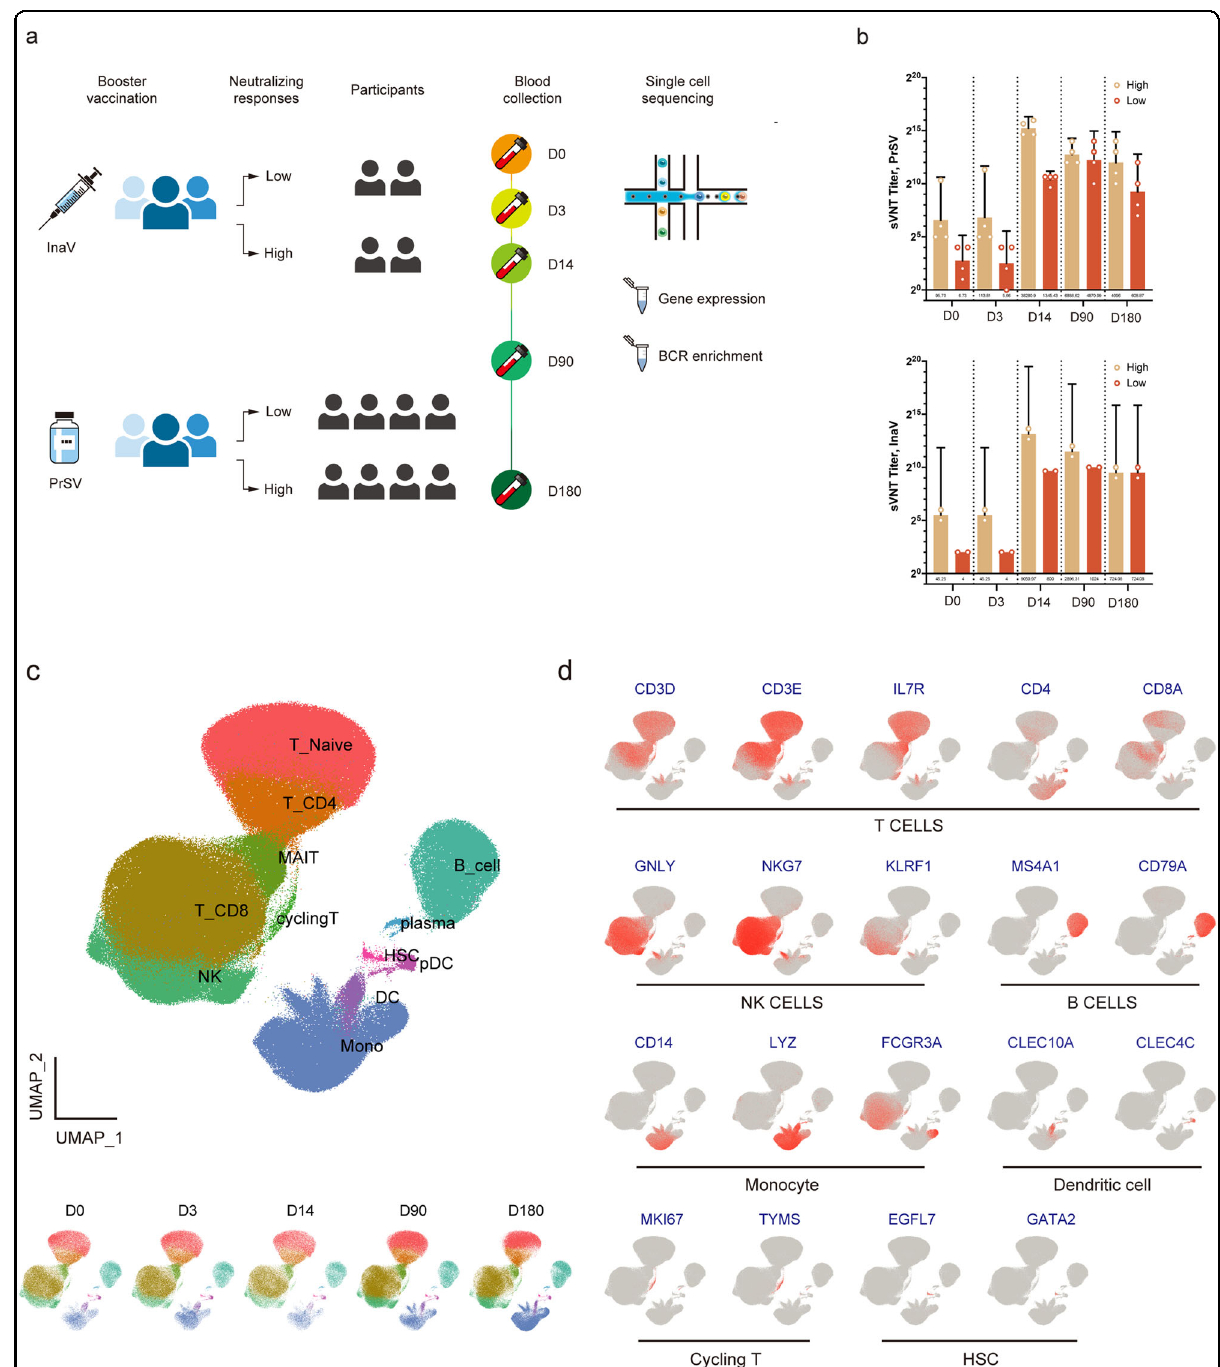
Fig. 2 Pro fi ling of PBMCs by scRNA-seq and scV(D)J-seq. a Schematic diagram showing the experimental design for scRNA-seq and scV(D)J-seq. PBMCs were collected from 12 participants. b Humoral immune responses (sVNT) of each sample at Day0, Day3, Day14, Day90 and Day180 in PrSV group (top) and InaV group (bottom), respectively. c UMAP representation of PBMCs from all participants and time points sampled (top), and UMAPs annotated by time point separately (bottom). Cell types were identi fi ed by cluster gene signatures and color-coded. Each dot represents an individual cell. d UMAP projection of canonical markers of each cell